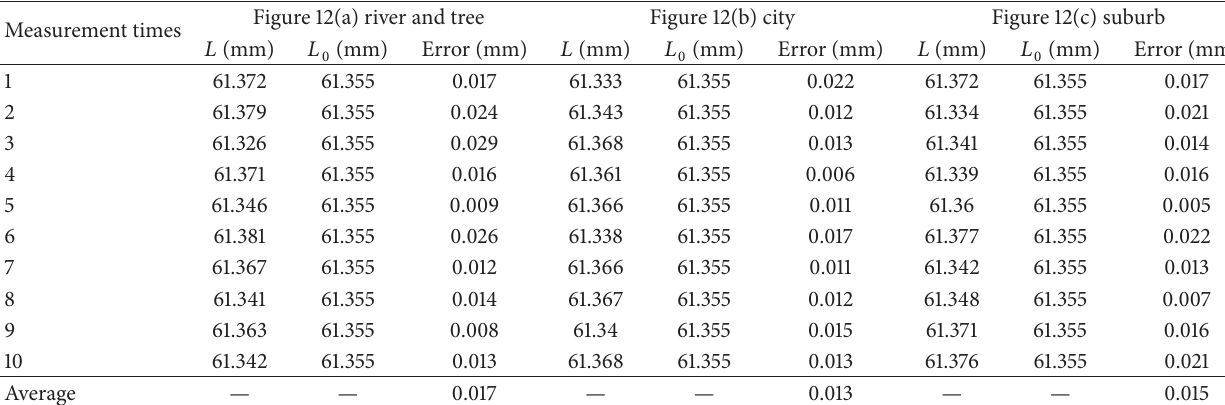
Table 2: Autofocusing experiment